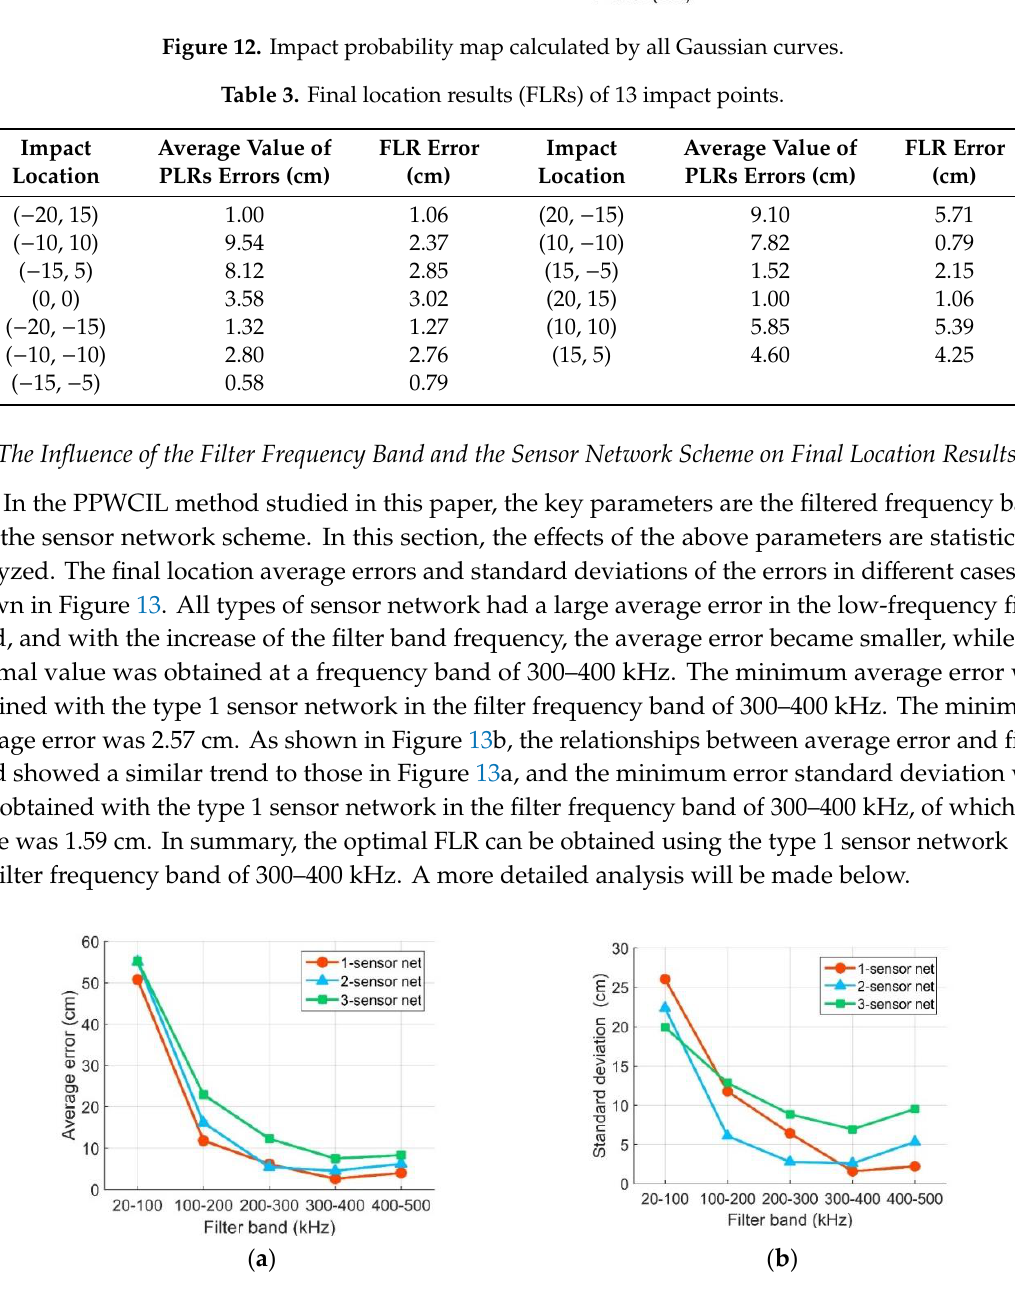
Figure 13. Performance comparison of the algorithm with different sensor network schemes and different filter bands: ( a ) average error curve; ( b ) standard deviation curve.